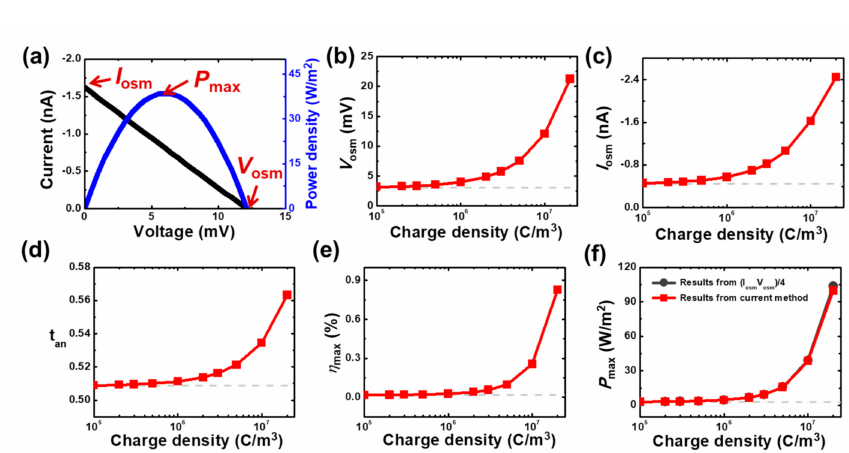
Figure 4. ( a ) Simulated current–voltage (I–V) and power density–voltage (P–V) curves of the considered mesopore system with a space charge density of ρ PE = 1 × 10 7 C/m 3 in a 1000 mM / 1 mM salinity gradient. The osmotic voltage ( V osm ) and current ( I osm ) can be obtained from the intercepts on the current and voltage axes, respectively. P max is the maximum osmotic power density